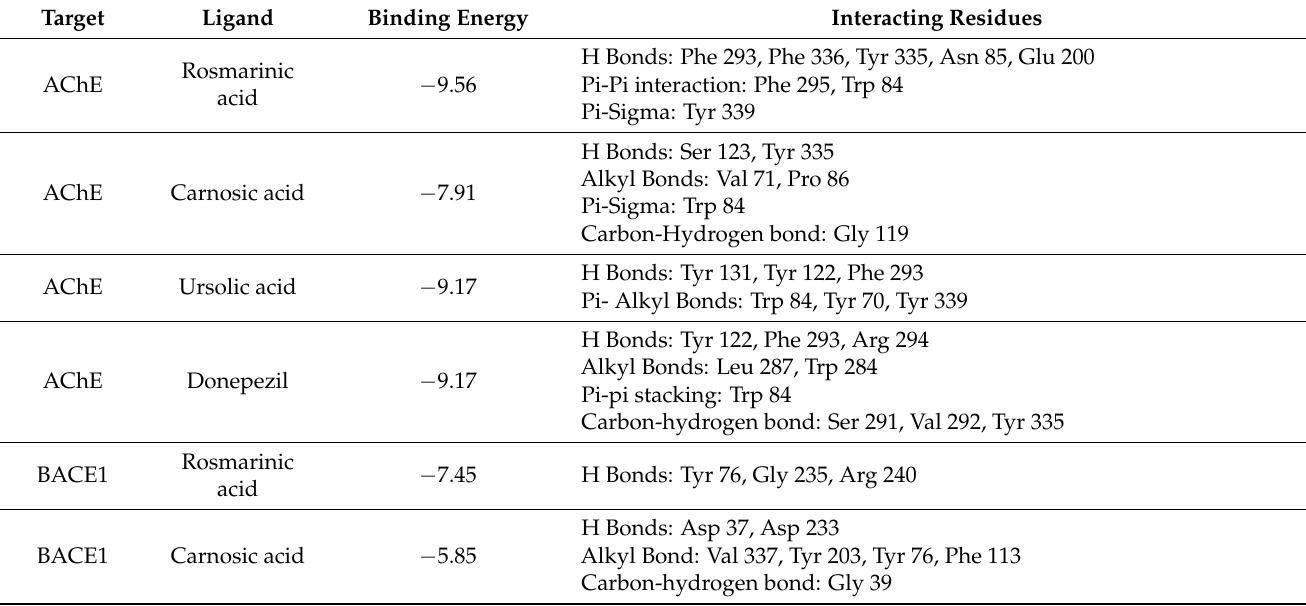
Table 1. 3D Docking interaction of R. officinalis active compounds with the target